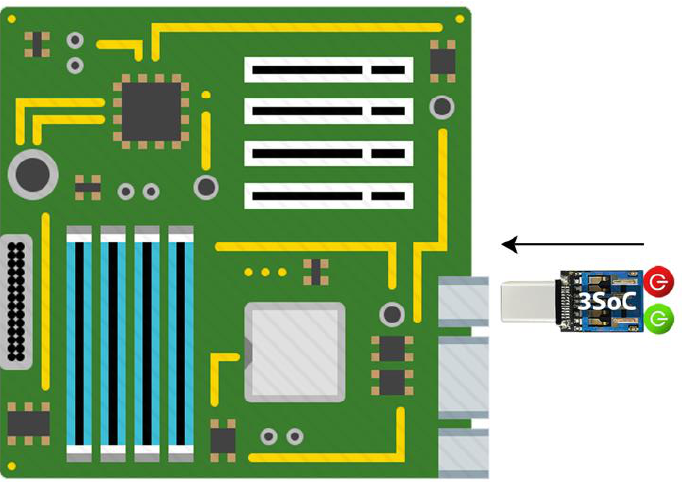
Figure 5. Integration of switchable 3SoC module with a computer motherboard.